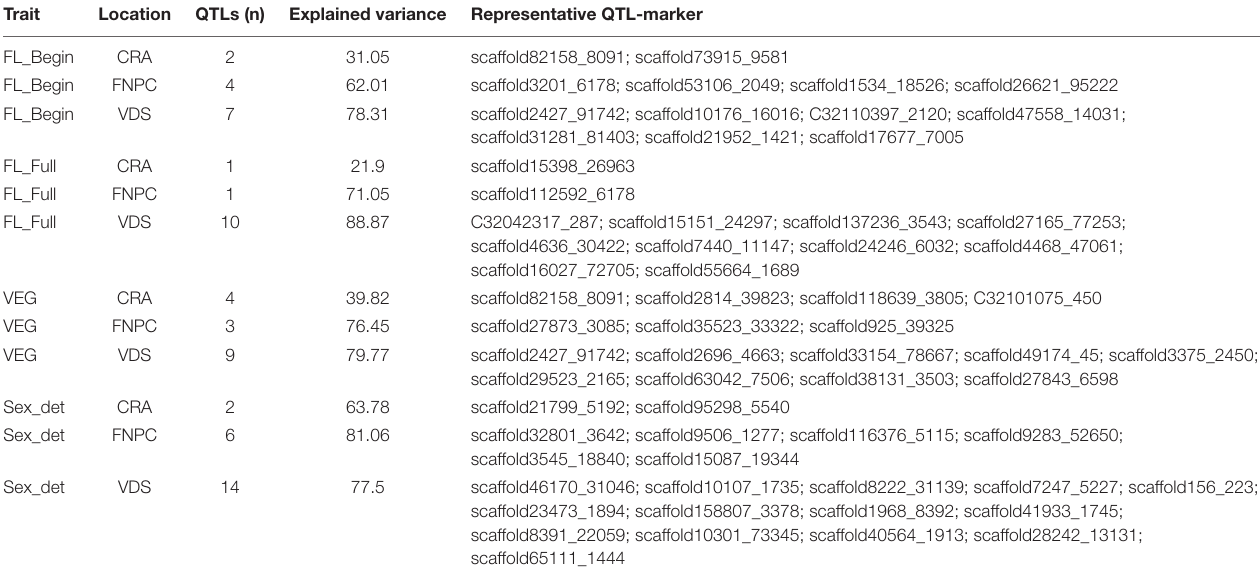
TABLE 2 | QTLs for flowering time traits and sex determination of hemp. Trait Location QTLs (n) Explained variance Representative QTL-marker